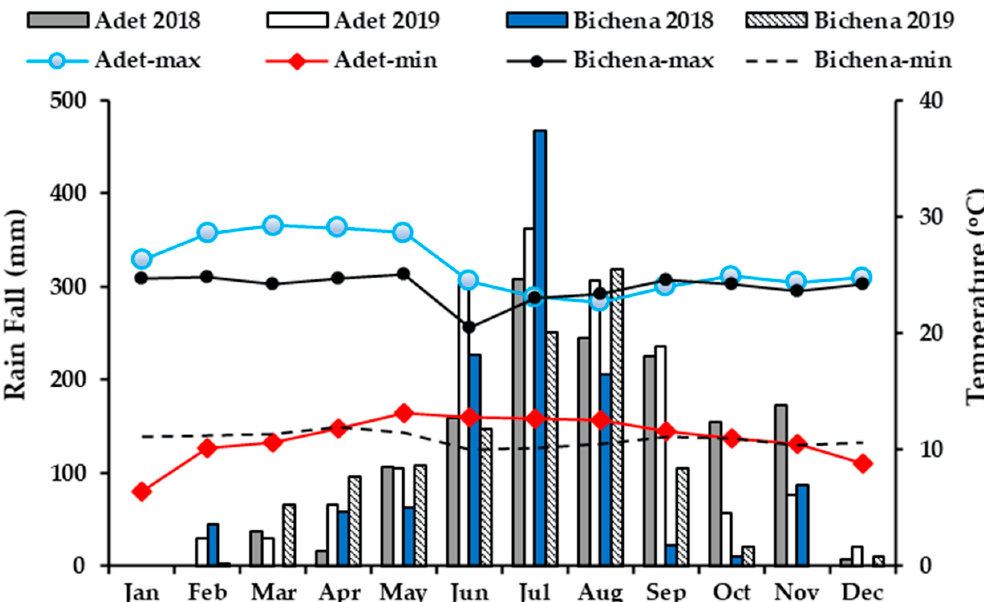
Figure 1. Monthly rainfall distribution (bars), maximum daily average temperature (max), and minimum daily average temperature (min) at the Adet and Bichena experimental stations during 2018 and 2019. The temperature data shown for each station are the averaged values of the two years. These data were provided by the Ethiopian Meteorology Agency, Bahir Dar region.